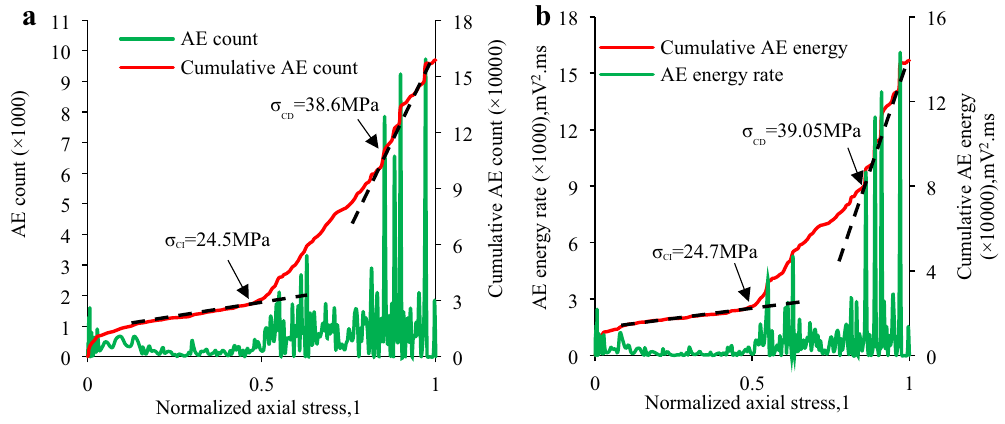
Figure 12. CI and CD thresholds of granite specimen in Test Case 4–1 ( θ = 20°) determined by AE energy and AE count: ( a ) CI and CD thresholds determined by AE count; ( b ) CI and CD thresholds determined by AE energy.